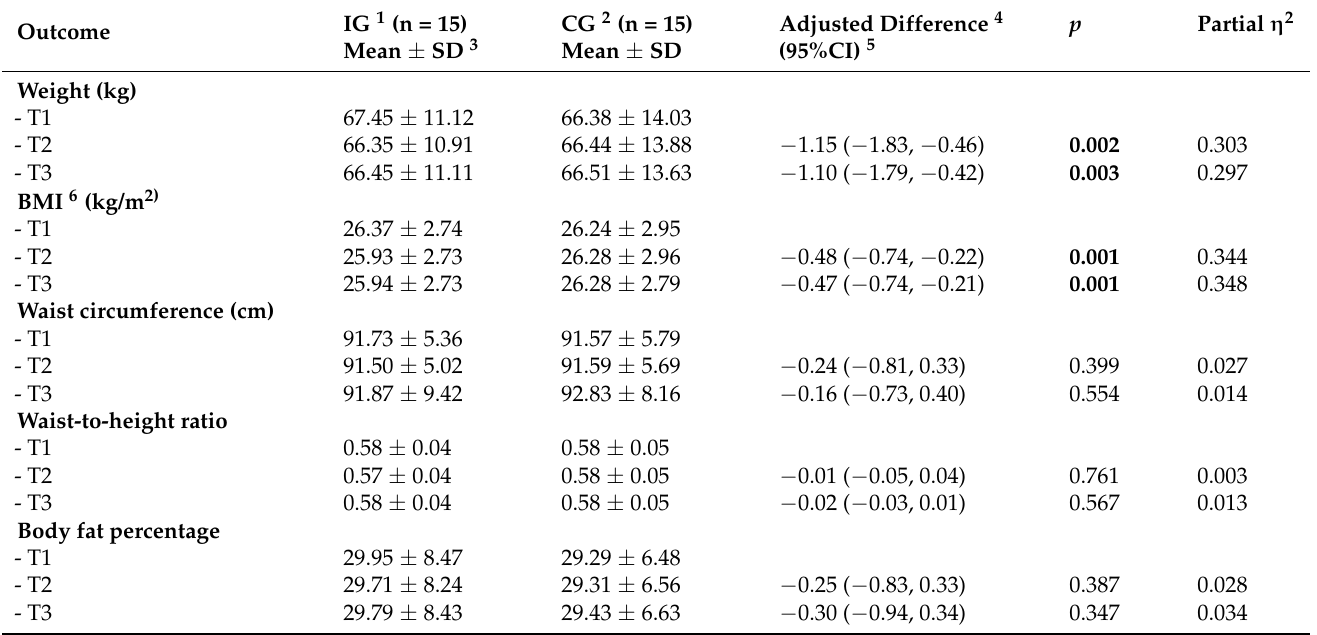
Table 4. Between-group differences in obesity-related